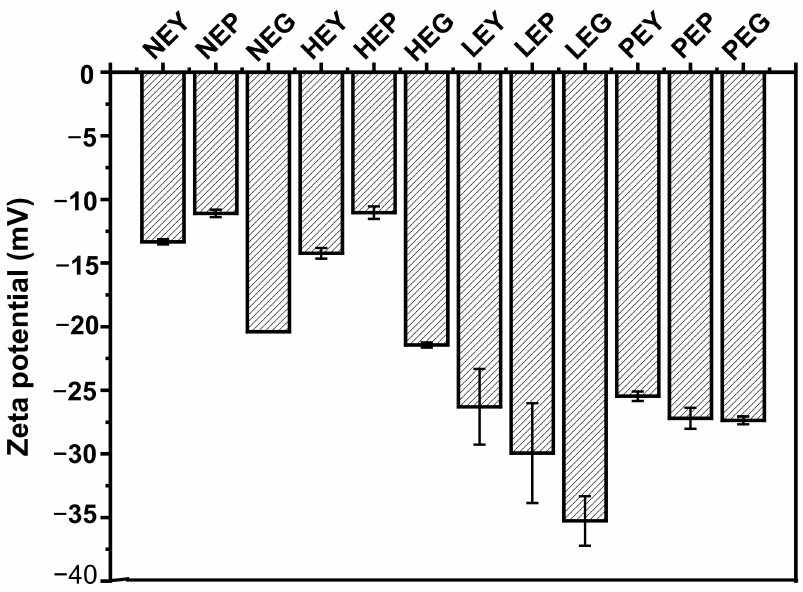
Figure 3. Zeta potential of egg yolk fractions (egg yolk, plasma and granule) under different treatments (heat treatment, hydrolyzed by lipase and hydrolyzed by phospholipase). NEY, NEP and NEG (natural egg yolk, natural egg plasma and natural egg granule, respectively); HEY, HEP and HEG (heated egg yolk, heated egg plasma and heated egg granule, respectively); LEY, LEP and LEG (egg yolk hydrolyzed by lipase, egg plasma hydrolyzed by lipase and egg granule hydrolyzed by lipase, respectively); PEY, PEP and PEG (egg yolk hydrolyzed by phospholipase, egg plasma hydrolyzed by phospholipase and egg granule hydrolyzed by phospholipase,